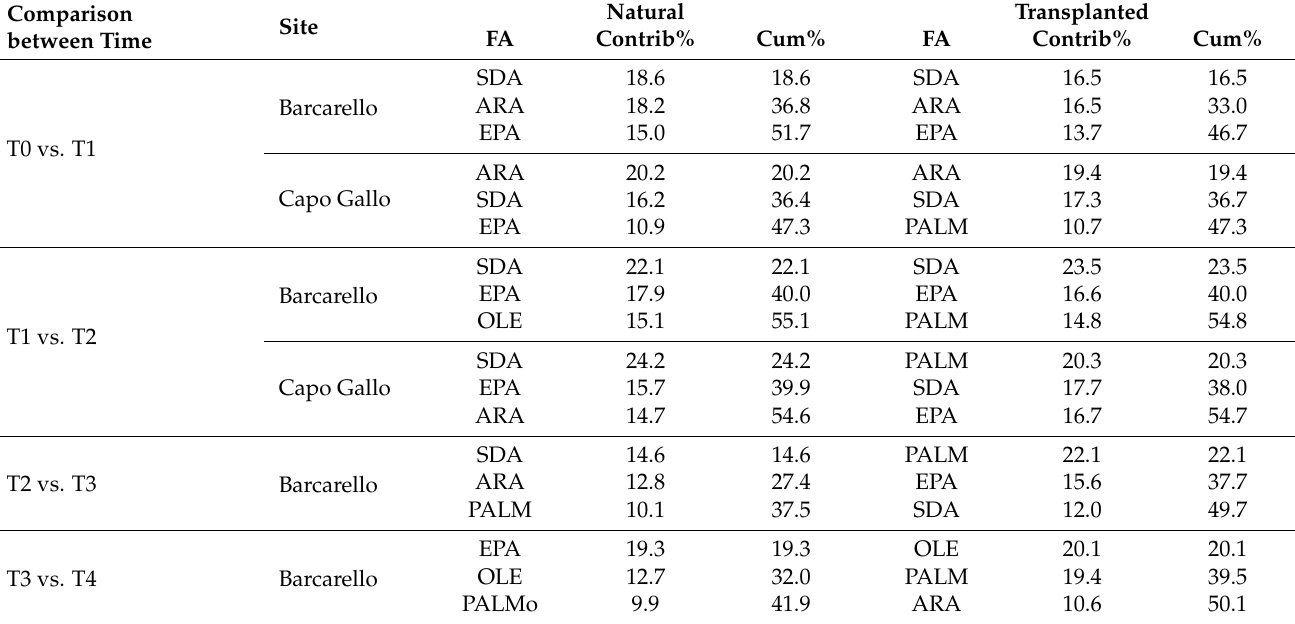
Table 3. SIMPER analysis showing fatty acids of Ericaria amentacea thalli that contribute most to the dissimilarity between times at each site and treatment.